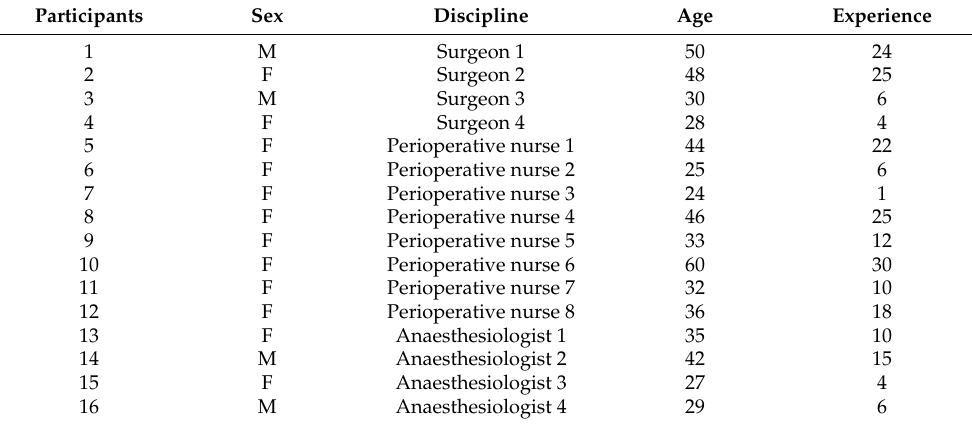
Table 2. Characteristics of study participants.